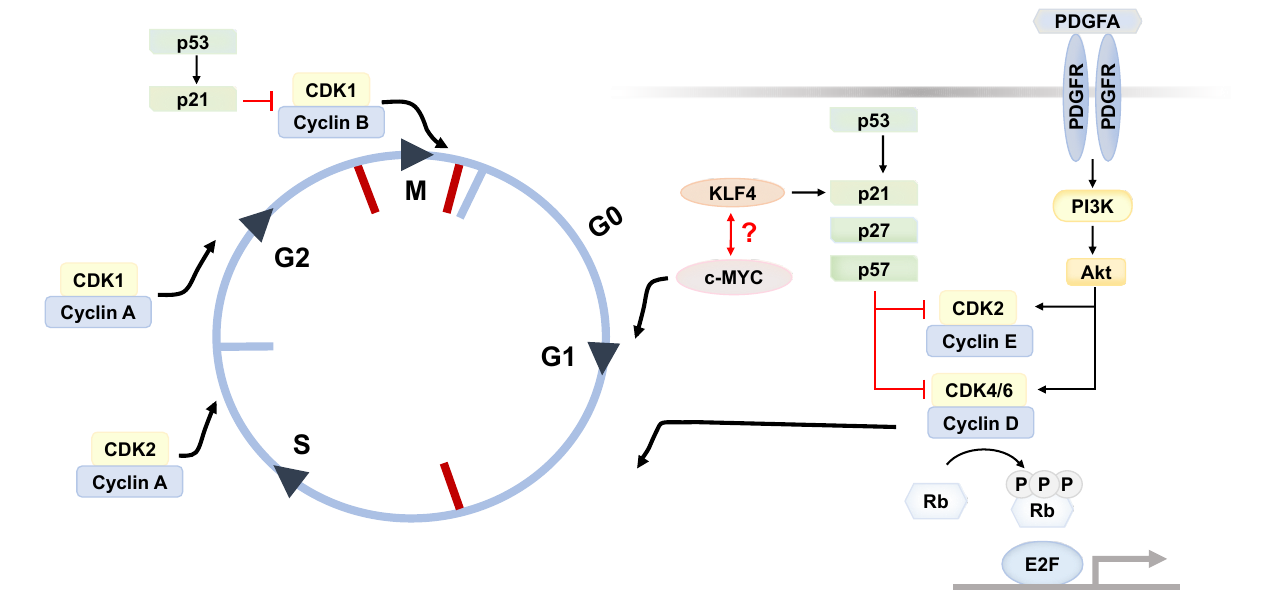
Figure 1. Schematic summary of cell cycle regulation in ASCs. The mammalian cell cycle is the process composed of four phases: growth 1 (G 1 ), DNA synthesis (S), growth 2 (G 2 ), as well as mitosis (M). Similar to other adult stem cells, it is often that ASC enters the quiescent state (G 0 ) when there are no mitogenic stimuli. To ensure the cellular quality, the cell cycle progression is controlled by three major checkpoints, including G 1 /S checkpoint, the G 2 /M checkpoint, and metaphase checkpoint (as indicated by red-colored bar). Mechanistically, these checkpoints are governed by the activity of cyclin and its partner cyclin-dependent kinase. For instance, the complex composed of E-type cyclin (Cyclin E) with cyclin-dependent kinase 2 (CDK2) inactivates the retinoblastoma protein (Rb) via phosphorylation (P), and in turn relieves the inhibitory effect on E2F transcription factor. As such, this enables ASC to undergo gene profile reprogramming for entering S phase. By contrast, the cell cycle progression can be arrested by CDK inhibitors via blocking the binding between cyclin and corresponding CDK.